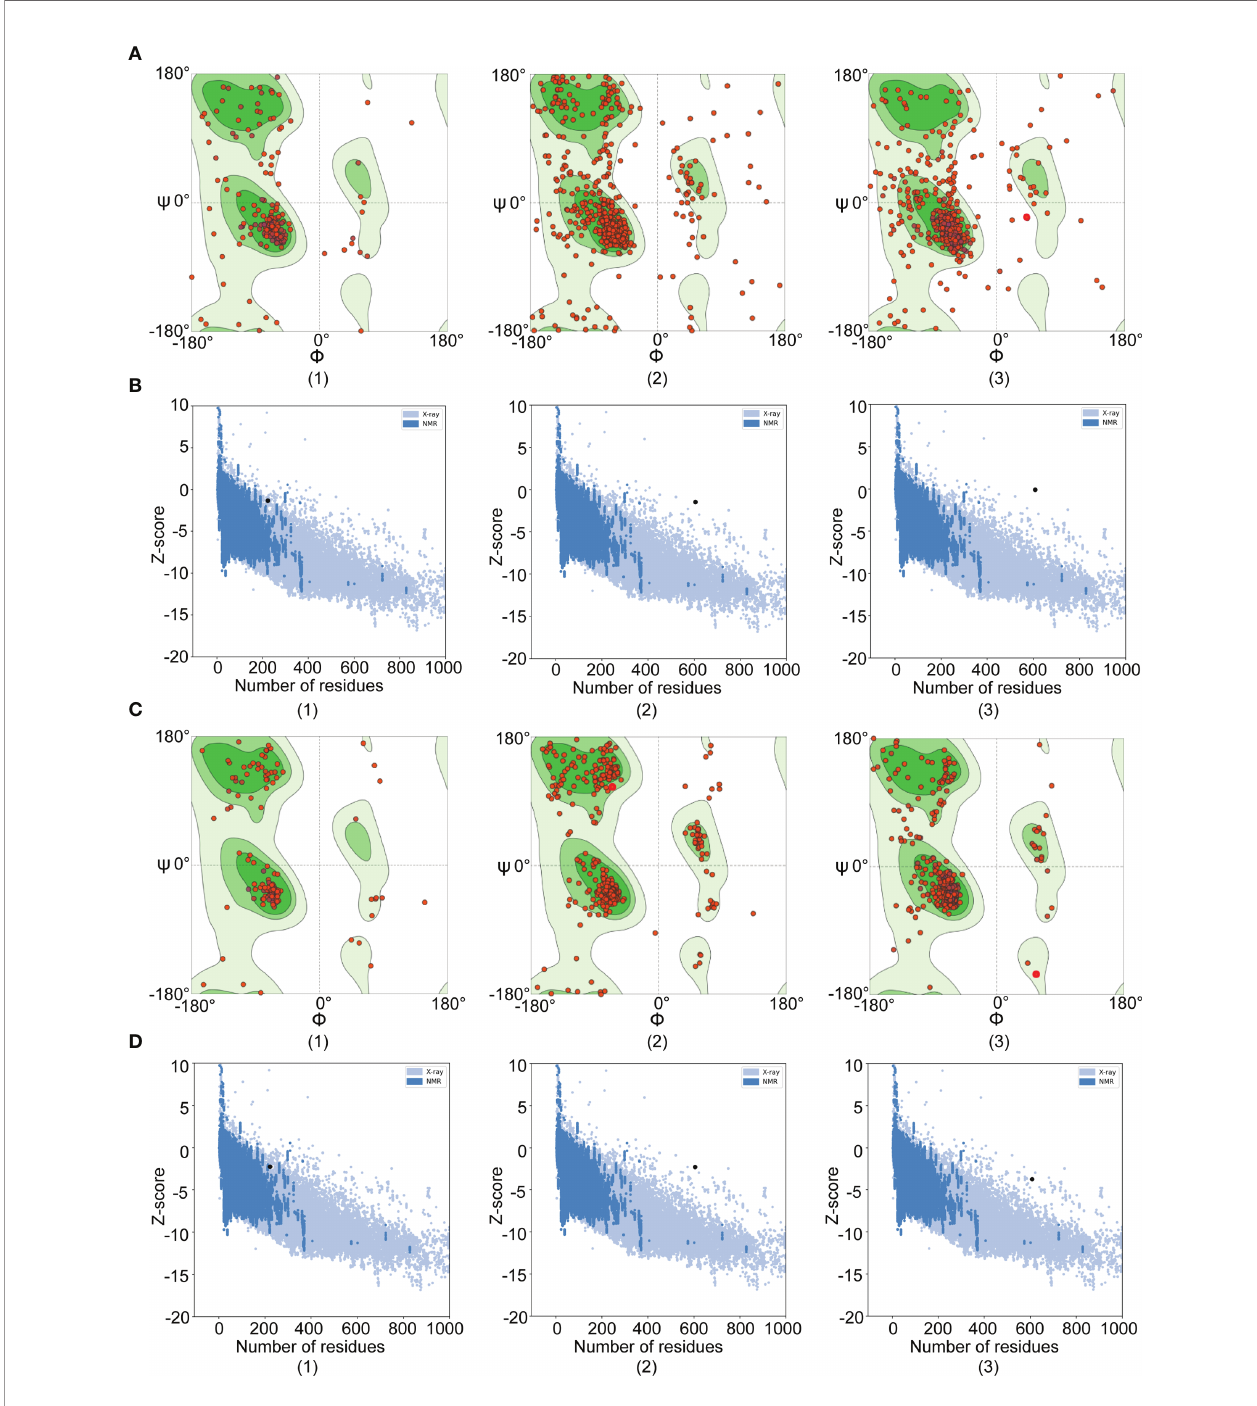
FIGURE 5 | Ramachandran and Z-score plots of initial and re fi ned 3D models. The results of Amastin-like protein, Amino acid permease, and hypothetical protein (XP_003865405.1) were respectively remarked with (1), (2), and (3). (A) Ramachandran plots of initial models: Amino acid permease showed 70.71% favored region and 11.83% outlier region; Amastin-like protein had 83.62% favored region and 6.90% outlier region; The hypothetical protein (XP_003865405.1) demonstrated 71.9% favored region and 14.05% outlier region. (B) Z-score plots of initial models: Amino acid permease, amastin-like protein, and the hypothetical protein (XP_003865405.1) were -1.48, -1.32, and -0.1 value, respectively. (C) Ramachandran plots of re fi ned models: Amino acid permease showed 91.21% favored region and 1.49% outlier region; Amastin-like protein had 90.45% favored region and 2.27% outlier region; The hypothetical protein (XP_003865405.1) demonstrated 92.73% favored region and 1.65% outlier region. (D) Z-score plots of re fi ned models: Amino acid permease, amastin-like protein, and the hypothetical protein (XP_003865405.1) were -2.27, -2.26, and -3.6 value,